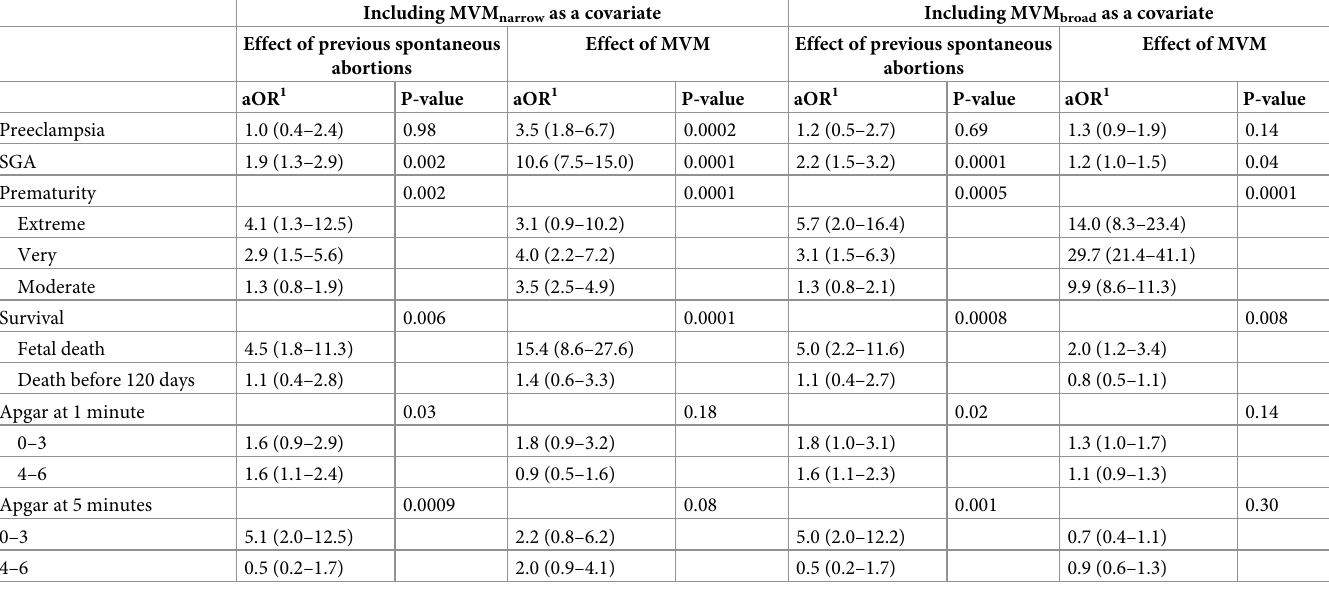
Table 6. Associations of previous spontaneous abortions and pregnancy outcomes including the presence of MVM lesions as a covariate.